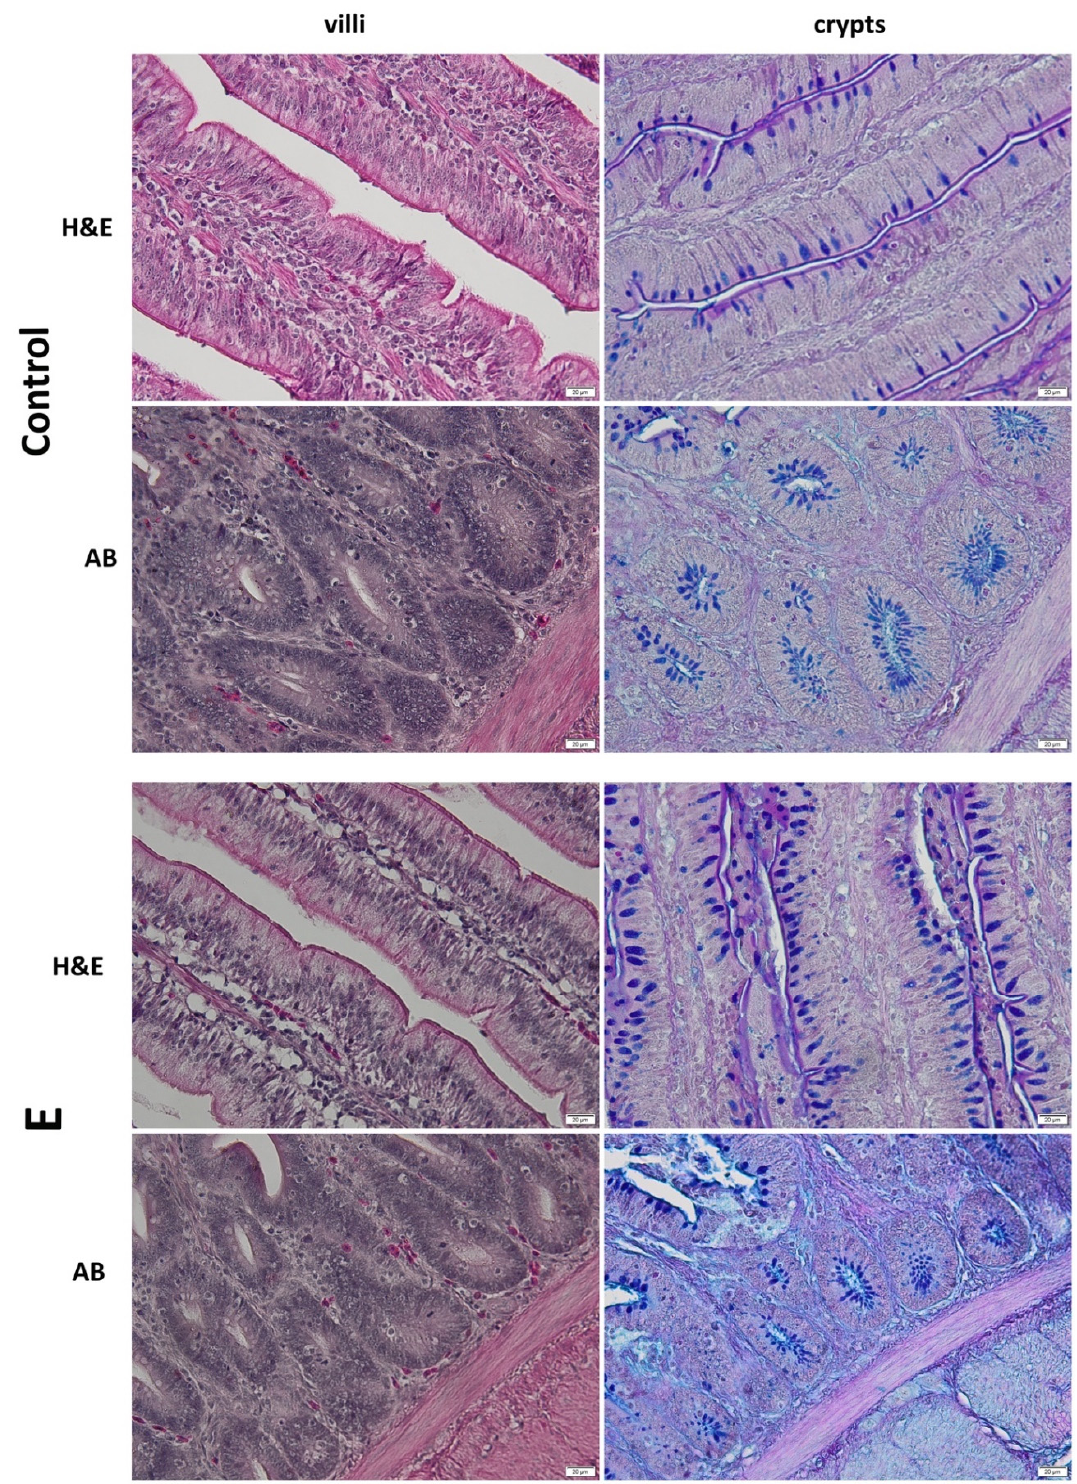
Table 5) the villus height, crypt depth, and villus height/crypt depth ratio compared with those of the control.